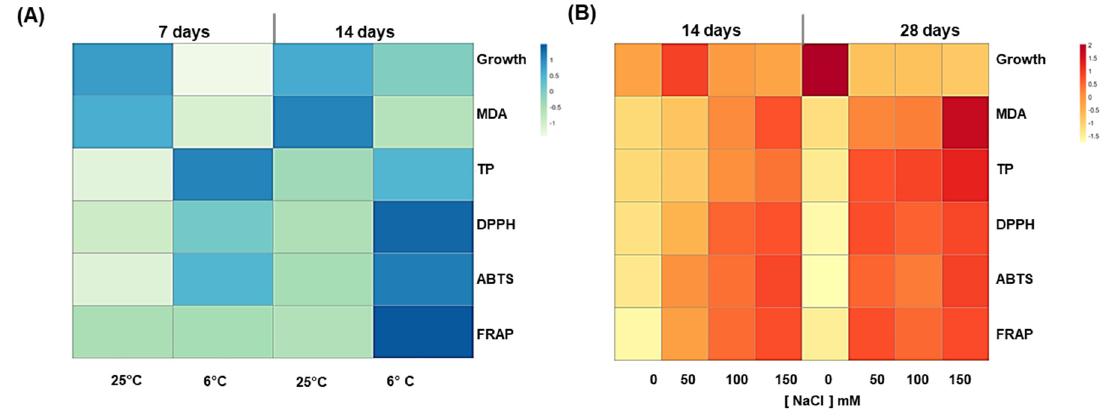
Figure 4. ( A , B ) Non-clustered heat map of major changes exerted by elicitation by abiotic stresses in cardoon calli. Heat maps for ( A ) 6 °C chilling stress treatment for 7 or 14 days, and ( B ) 0, 50, 100, or 150 mM NaCl salt stress treatment for 14 or 28 days. The columns of the heat maps represent control and stress treatments at the different time points, the rows represent different physiological and metabolic parameters (growth, lipid peroxidation MDA, total polyphenols, DPPH, ABTS, and FRAP assay). Each cell is colored based on the value in that sample. The intensity of color is representative of degree of differences; the value of 0 denotes no difference, with higher values corresponding to larger differences. Values from lower to higher are indicated by light green to blue for chilling stress and yellow to red for salt stress.